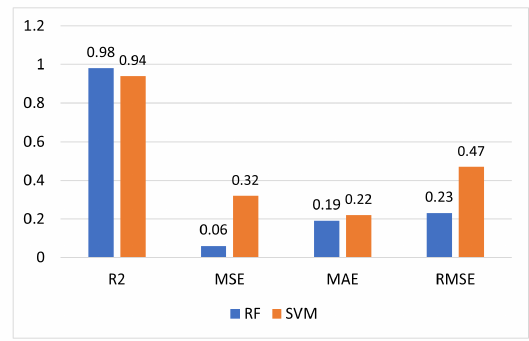
Figure 15. Comparison of the performance